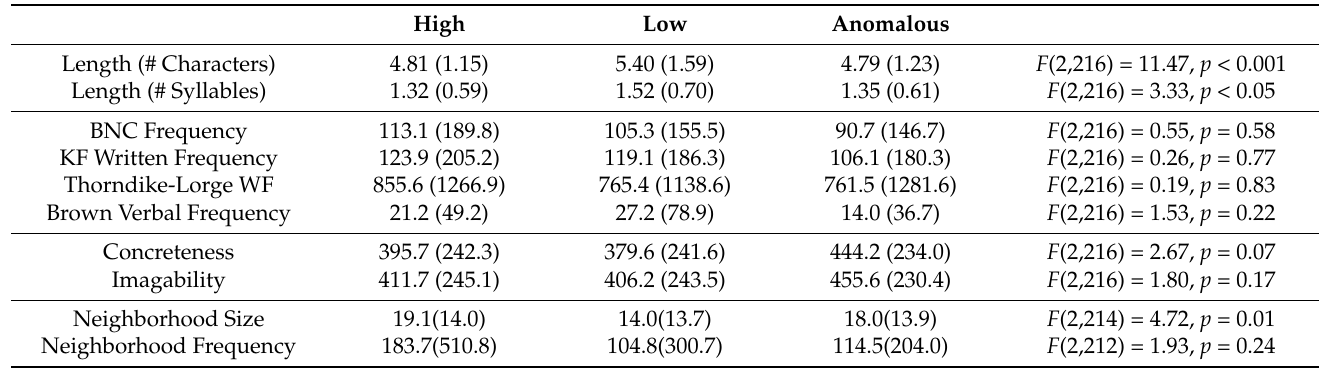
Table 2. Means and standard deviations for lexical variables of final